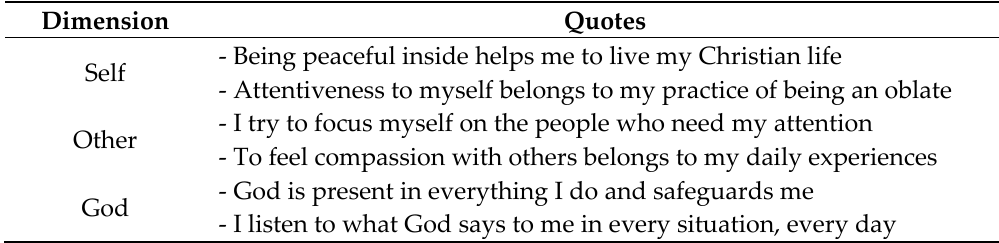
Figure 3. Dimensions of everyday practices—quotes.